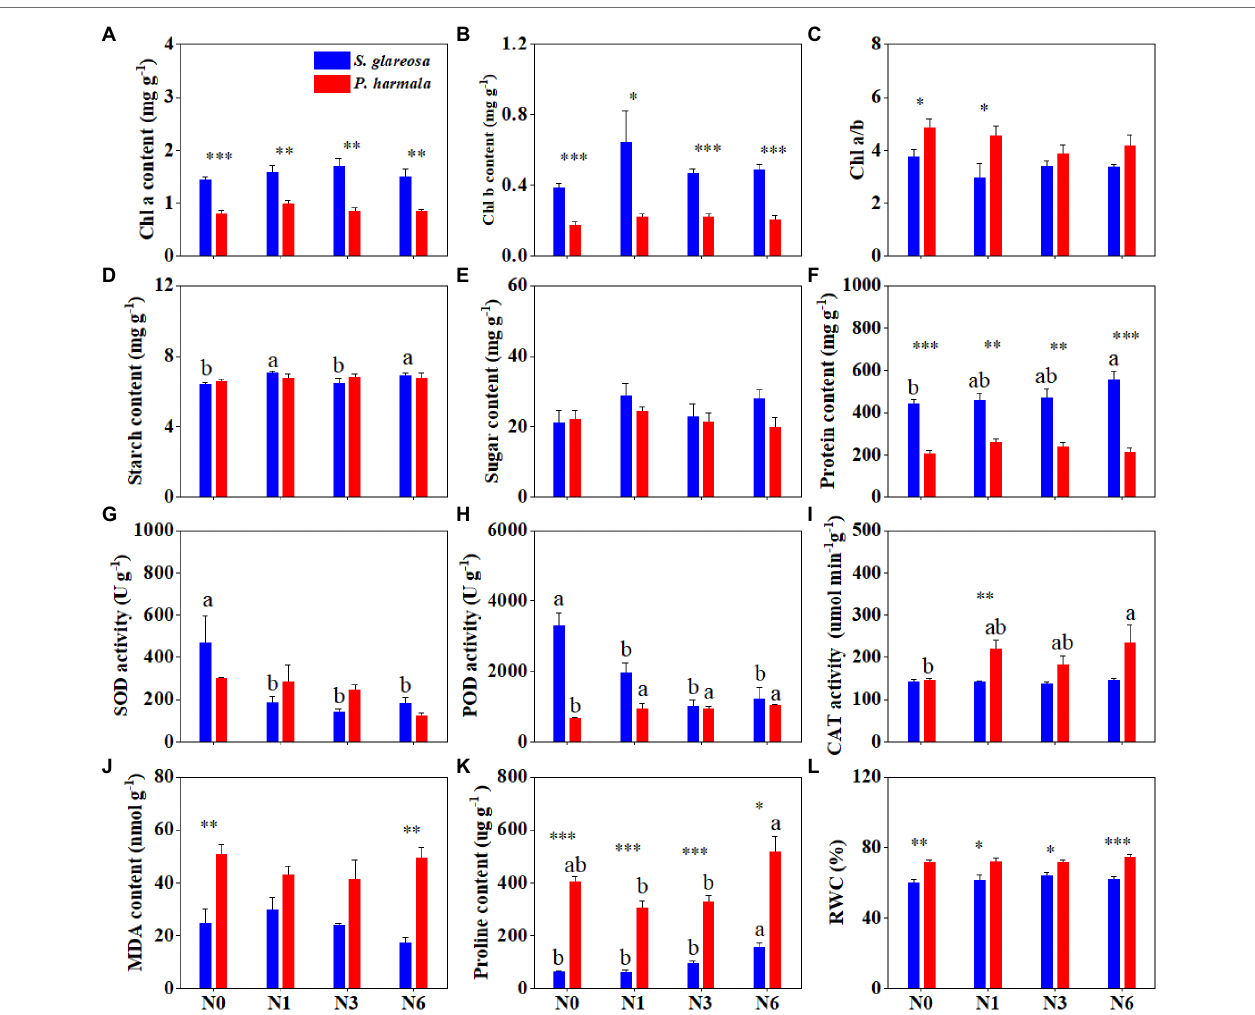
FIGURE 2 | Response of leaf physiological traits in S. glareosa and P. harmala to different N treatments. (A) Chlorophyll a (Chl a) content, (B) chlorophyll b (Chl b) content, (C) chlorophyll a-to-b ratio (Chl a/b), (D) starch content, (E) soluble sugar content, (F) soluble protein content, (G) superoxide dismutase (SOD) activity, (H) peroxidase (POD) activity, (I) catalase (CAT) activity, (J) malondialdehyde (MDA) content, (K) proline content, and (L) relative water content (RWC). Different lower-case letters represent significant differences among the treatments for each species ( p < 0.05). Asterisks represent significant differences between S. glareosa and P. harmala (* p < 0.05; ** p < 0.01; and *** p <